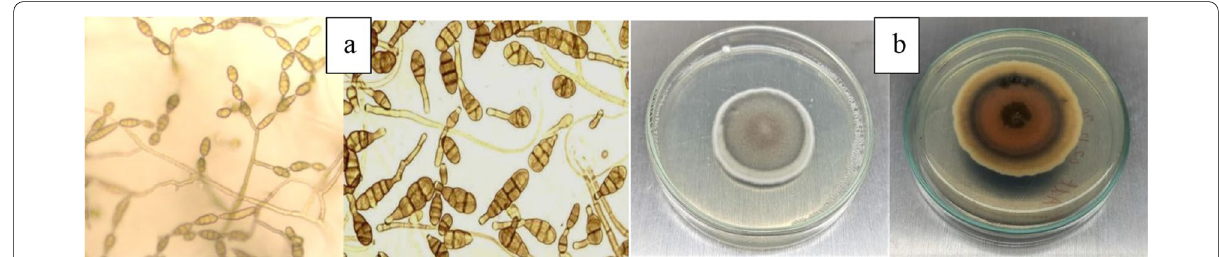
Fig. 1 a Spores of Alternaria alternata VLH1, b fungal colony on PDA